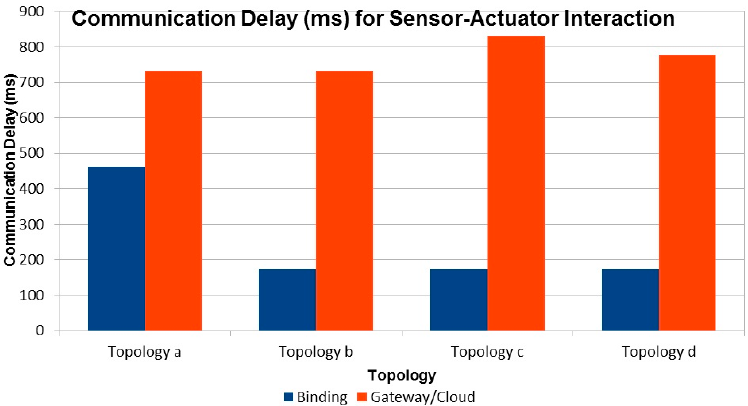
Figure 16. Communication Delay (ms) vs. Topology.